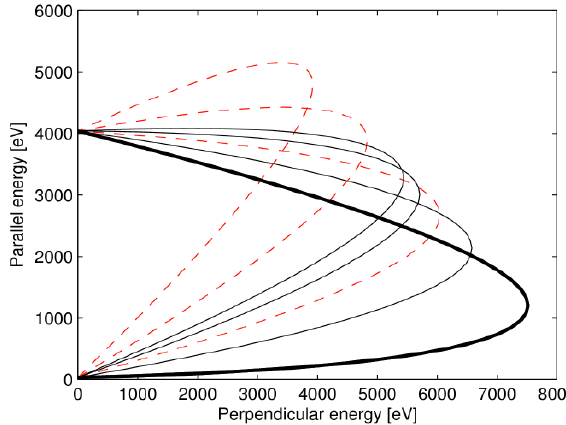
Fig. 2. Model result for an isocontour of a distribution moving to progressively higher altitude and the associated folding of the dis- tribution function into a “conic” for a dipole field (red dashed lines) and the average observed background magnetic field (thin black lines) as function of altitude. The x-axis shows the perpendicular energy [eV] and the y-axis the parallel energy [eV]. The start alti- tude corresponds to 12 R E , and the three conics correspond to the altitudes 13, 14 and 15 R E